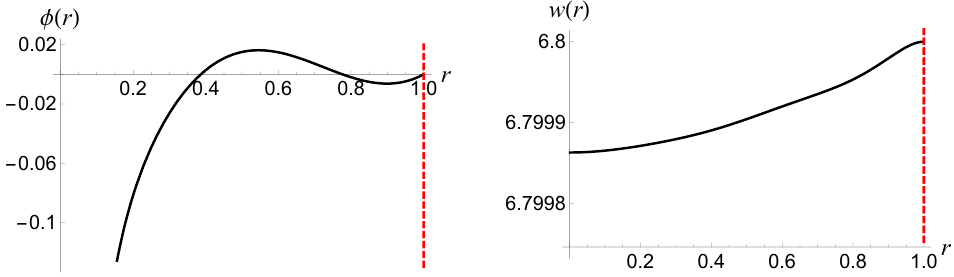
Figure 5 . The functions describing the one-form potential A = φ ( r ) τ 3 dt + w ( r ) τ 1 dx . The A t component exhibits some oscillatory behavior before diverging. The A x component decreases towards the black hole singularity but numerically appears to asymptote to a finite value.